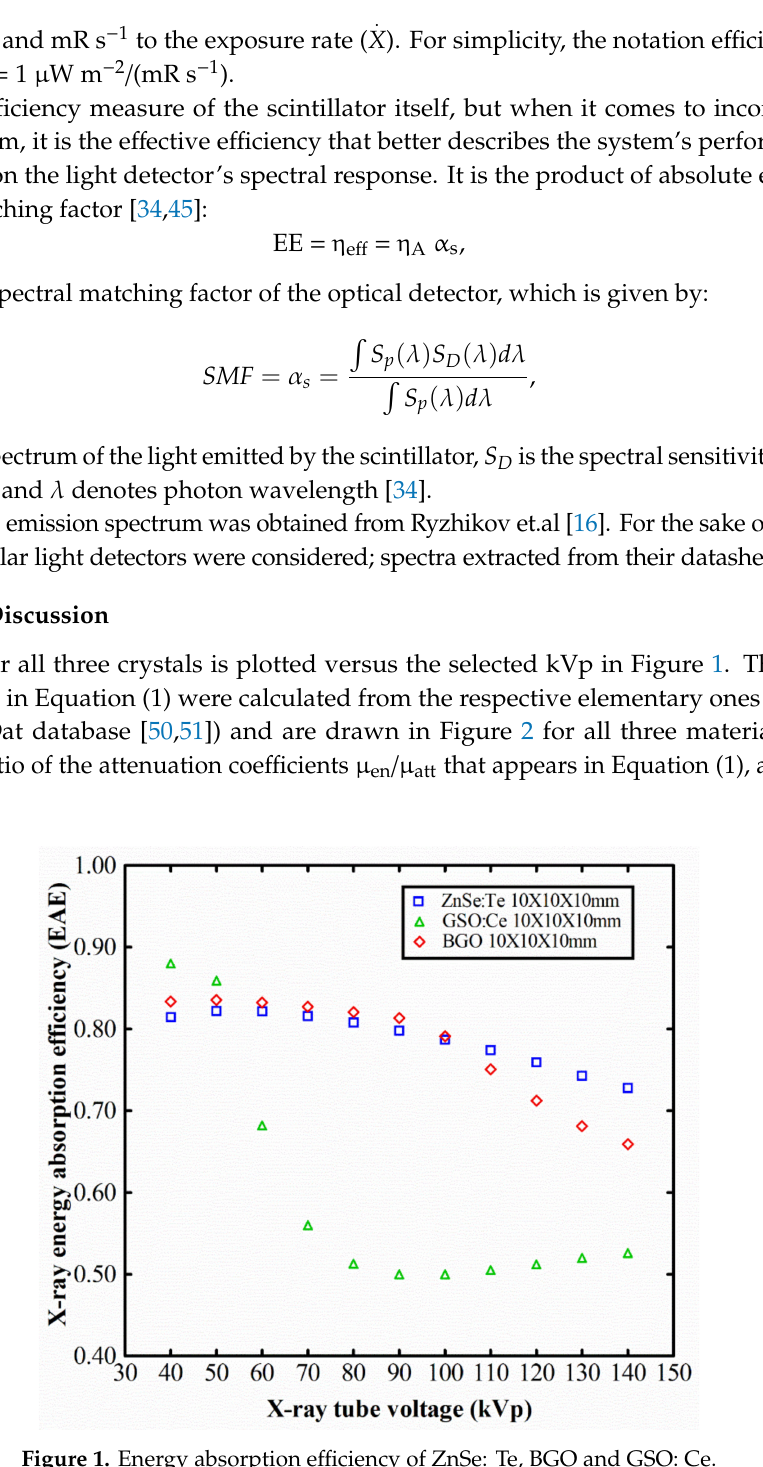
Figure 1. Energy absorption e ffi ciency of ZnSe: Te, BGO and GSO: